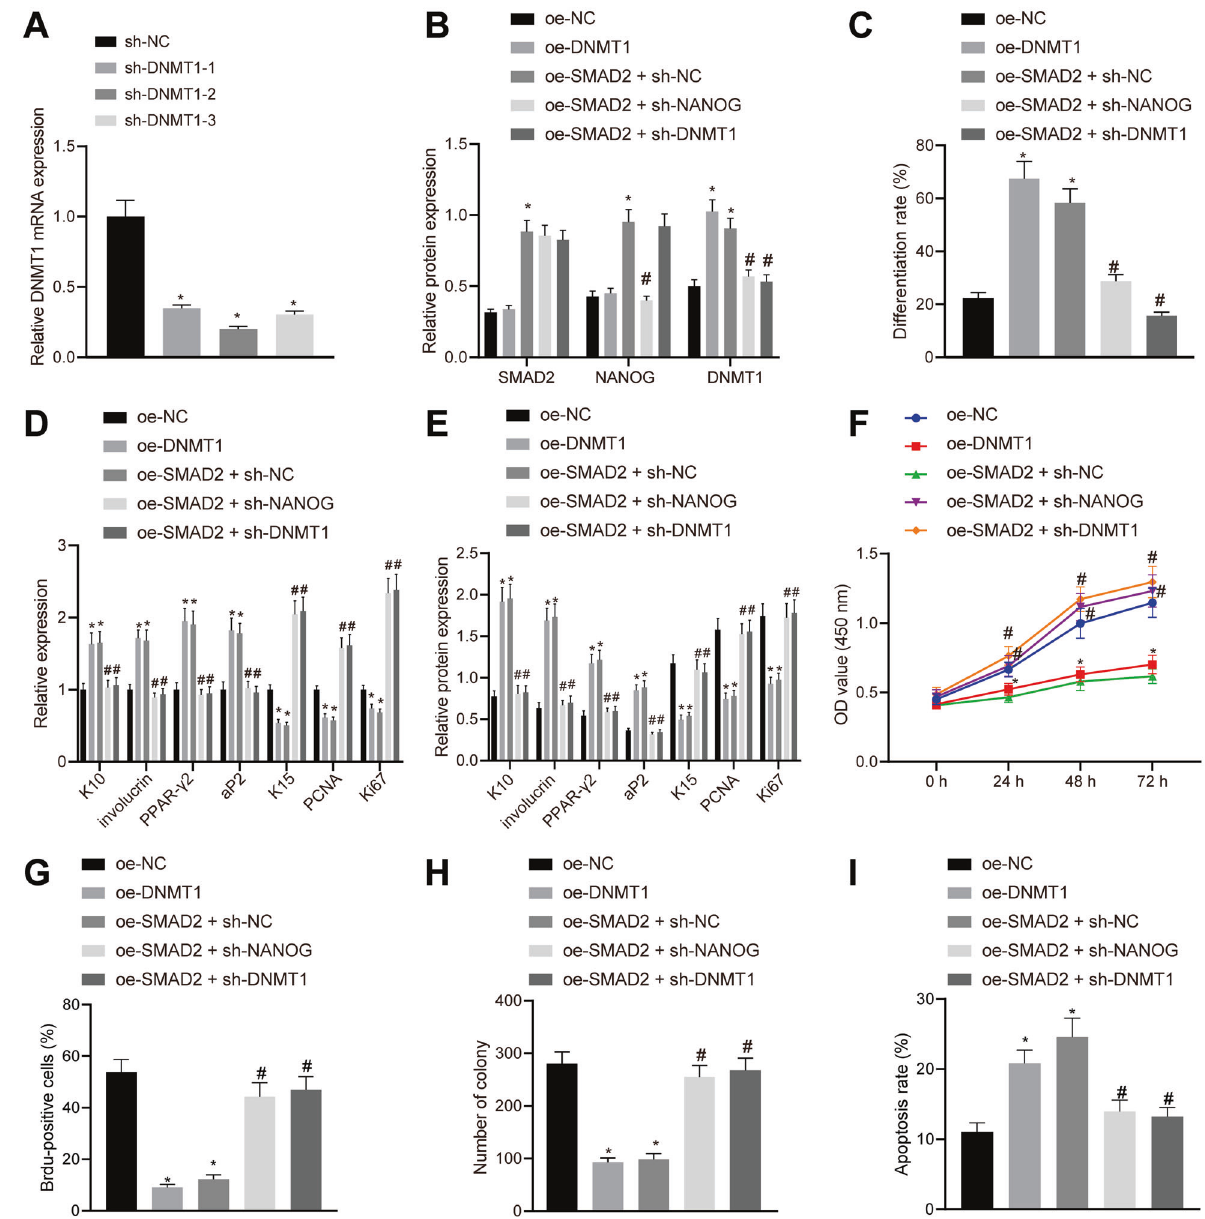
Fig. 5 SMAD2 promotes HFSC differentiation and apoptosis while suppressing cell proliferation by activating the NANOG/DNMT1 axis. A Silencing ef fi ciency of 3 siRNAs targeting DNMT1 in HFSCs determined by RT-qPCR, with β -actin as internal reference. * p < 0.05 vs. sh-NC group. B SMAD2, NANOG, and DNMT1 protein levels in HFSCs after different treatments measured by western blot assay, with β -actin as internal reference. C Differentiation rate of HFSCs after different treatments determined by oil Red O staining. mRNA ( D ) and protein ( E ) levels of epidermal differentiation markers (K10 and involucrin) and adipogenesis markers (PPAR- γ 2 and aP2), keratinocyte-speci fi c marker (K15), and proliferation-related markers (PCNA and Ki67) in HFSCs after different treatments determined by RT-qPCR and western blot assay, with β -actin as internal reference. F Cell viability after different treatments determined by CCK-8 assay. G Cell proliferation after different treatments assessed by BrdU labeling. H The number of colonies formed in HFSCs after different treatments. I Cell apoptosis after different treatments determined by fl ow cytometry, * p < 0.05 vs. oe-NC group; # p < 0.05 vs. oe-SMAD2 + sh-NC group. Data are expressed as mean ± standard deviation. Data between multiple groups were compared by one-way ANOVA with Tukey ’ s post hoc test while data at different time points were compared by two-way ANOVA with Bonferroni post hoc test. Each cell experiment was repeated 3 times. KRT5 and KRT10 in the wounded tissues, whereas SMAD2 or decreased the wound healing area on days 6, 10, and 14. NANOG overexpression countered the effect of Smurf2 on these Meanwhile, either SMAD2 or NANOG overexpression could reverse factors (Fig. 6D). In addition, western blot assay results presented the inhibitory effect of Smurf2 overexpression on the wound that oe-Smurf2 treatment elevated the protein levels of Smurf2 healing area (Fig. 6B, C). On day 18 after wounding, the skin tissues while reducing those of SMAD2, NANOG and DNMT1 in the skin at the wounded site were extracted, and the data obtained from tissues from mouse wound model, while further treatment with western blot assay demonstrated that Smurf2 overexpression oe-SMAD2 reversed these effects. Treatment with oe-Smurf2 + oe- decreased the levels of growth factors TGF- β 1, VEGF, PDGF-BB,